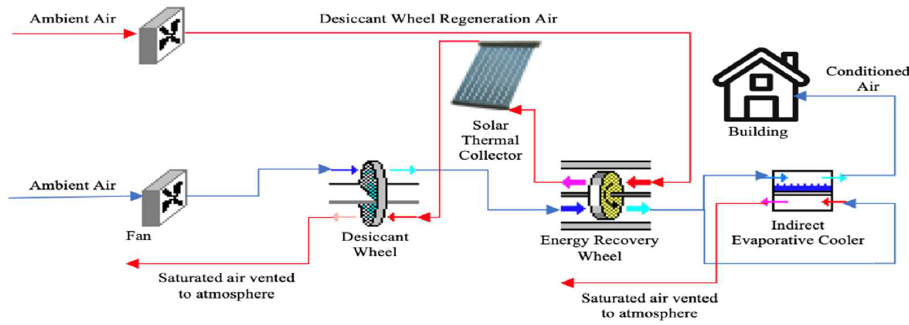
Figure 4. Proposed system using ambient air to regenerate the desiccant wheel.